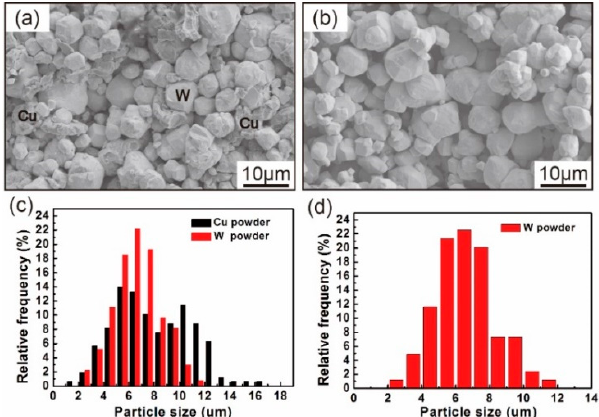
Figure 1. Microstructure morphology of skeletons: ( a ) W-Cu skeleton; ( b ) W skeleton. Size distribution characteristics of skeletons: ( c ) W-Cu skeleton; ( d ) W skeleton.